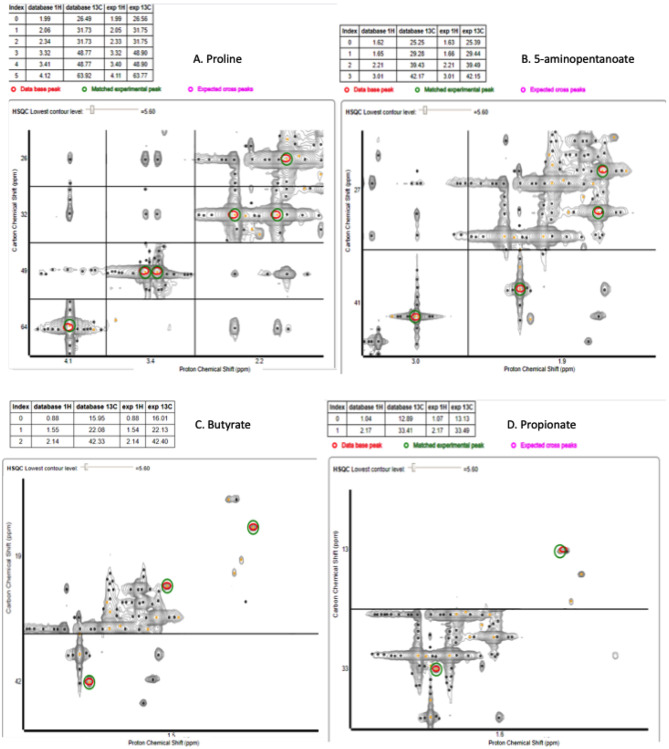
2D HSCQ NMR spectra for one day 7 10 mM C13-labeled proline supplemented biofilm spent saliva sample. The red circles identify the peaks within the database, and the green circles identify the matched experimental peak from the sample. The experimental peaks match all database peaks for proline (A), 5-aminopentanoate (B), butyrate (C), and propionate (D).